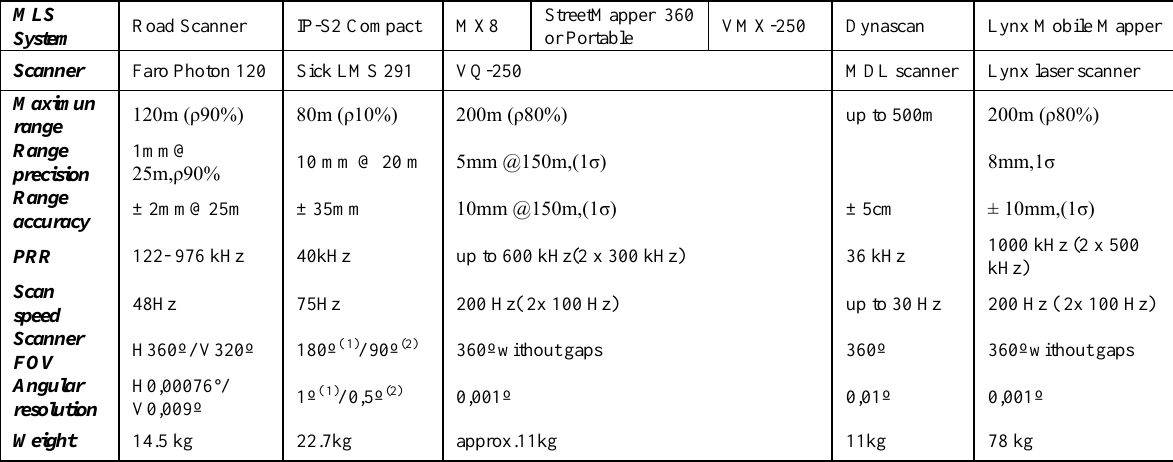
Table 1. Laser scanner specifications of MLS systems reviewed. The ROAD-SCANNER system uses a non-showerproof 3D Faro Photon 120, a phase difference scanner showing intermediate solutions between TOF scanners (mainly used for long-range measurement applications) and high-accurate triangulation ones. Although it is a 3D scanner, it works as a 2D device with its horizontal movement fixed when it is mounted on the vehicle. Because of its physical configuration, it has a blind spot (vertical FOV is 320º) that SITECO typically locates in the